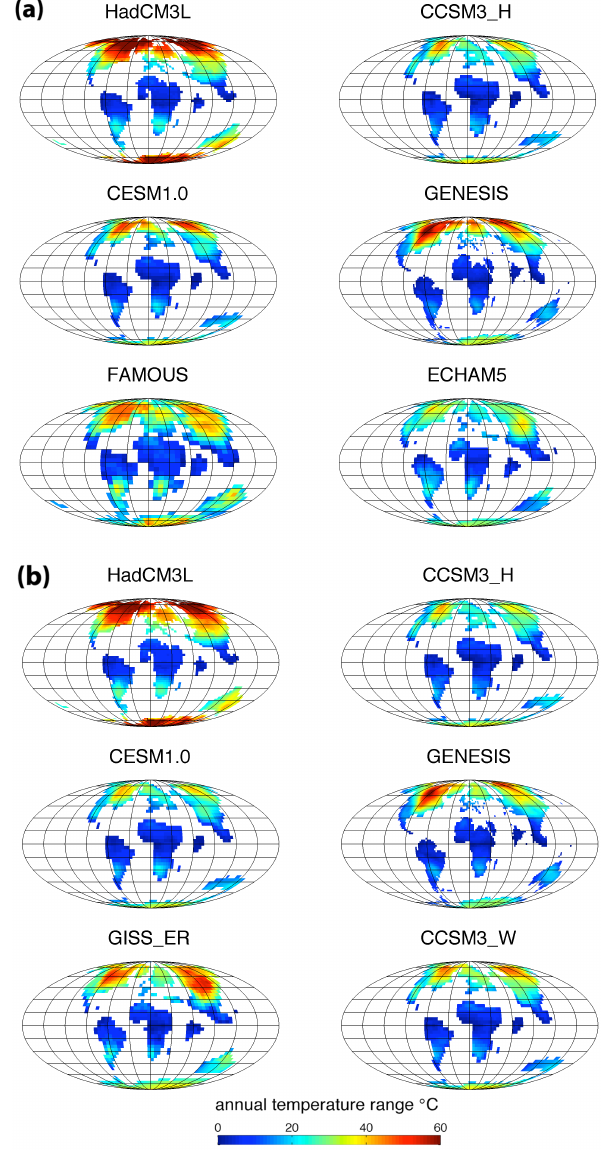
Fig. 9. Annual surface air temperature range over land from Eocene GCM simulations at (a) 2 × PIC and (b) 4 × PIC. et al. (2008) using another GCM; especially considering that the regions of low seasonality in the Northern Hemisphere, the west of North America and northeast Asia are also the regions where ice first nucleates in their ISM simulations (DeConto et al.,